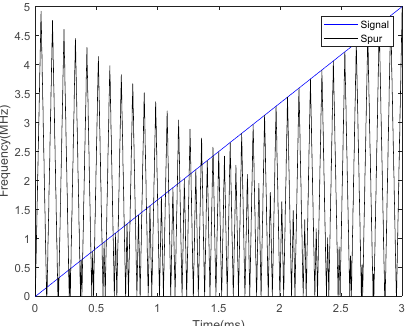
Figure 8. Frequency relation diagram of signal and spurious.